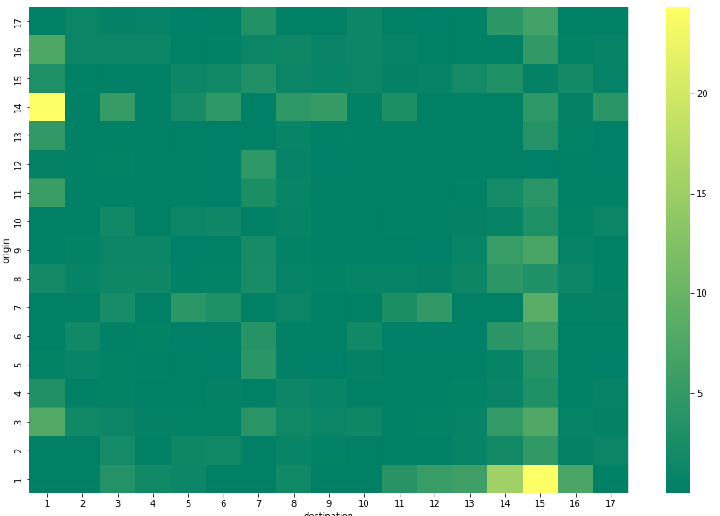
Figure 13. Relative error between the generated and estimated OD matrix of pedestrian trips. The total error of the pedestrian package with the synthetic data is computed in Equation